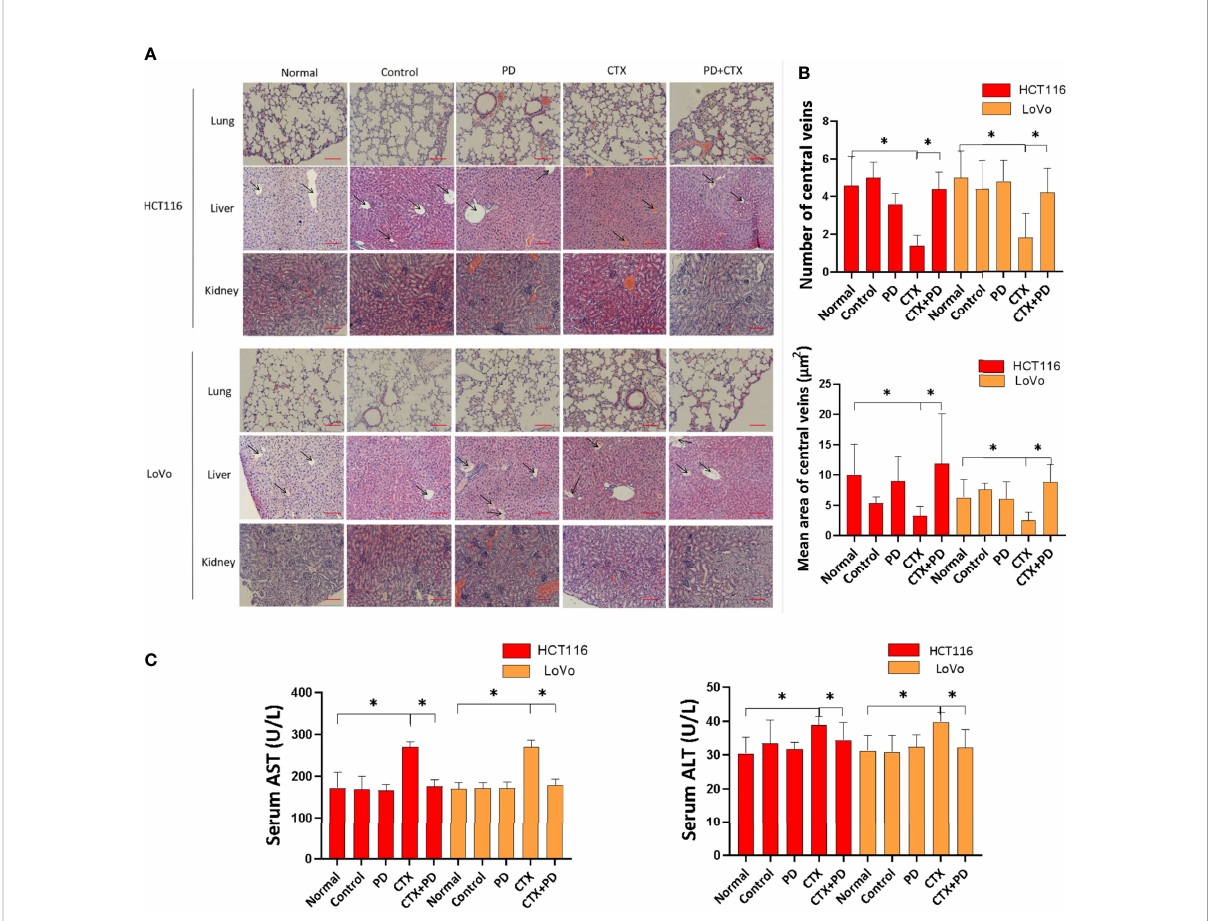
FIGURE 9 Hematoxylin and eosin staining assay of the lung, liver, and kidney. (A) Images of hematoxylin and eosin stained tissues. The left column shows cell types of subcutaneous tumor and types of stained tissue. The top line shows drug treatments, where ‘ Normal ’ represents healthy mice, and ‘ Control ’ represents tumor-burdened mice without drug treatment. Scale bars, 100 m m. (B) Quantitation of the number and vessel area of central veins in the hepatic lobules in every group. ImageJ was used to quantify the vessel diameter of central veins. Five pictures of the liver used in the column diagram were added as Figure S3 in Supplementary Materials. (C) Concentrations of serum AST and ALT were determined in mice in different groups. Data are shown as the mean ± S.D. One-way ANOVA was used to analyze P values between groups. All groups are compared with the ‘ Normal ’ group, and the ‘ CTX ’ group is compared with the ‘ CTX+PD ’ group. * P < 0.05 represents a signi fi cant